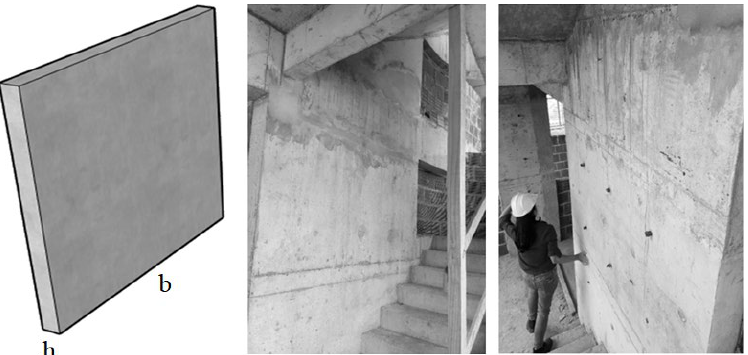
Figure 1. Simple planar shear wall geometry and its use in a RC building [5]